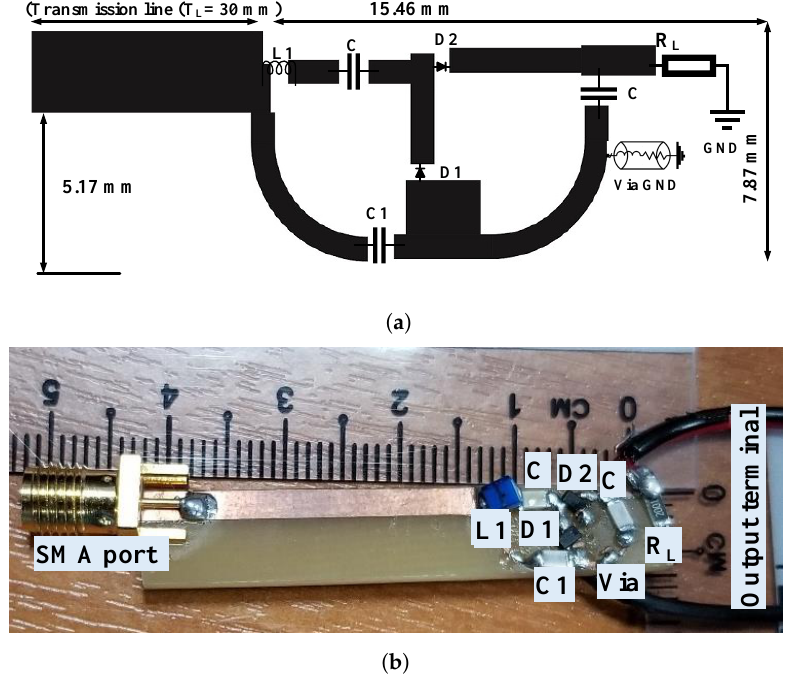
Figure 3. Rectifier proposed topology: ( a ) EM model layout, ( b ) fabricated prototype.